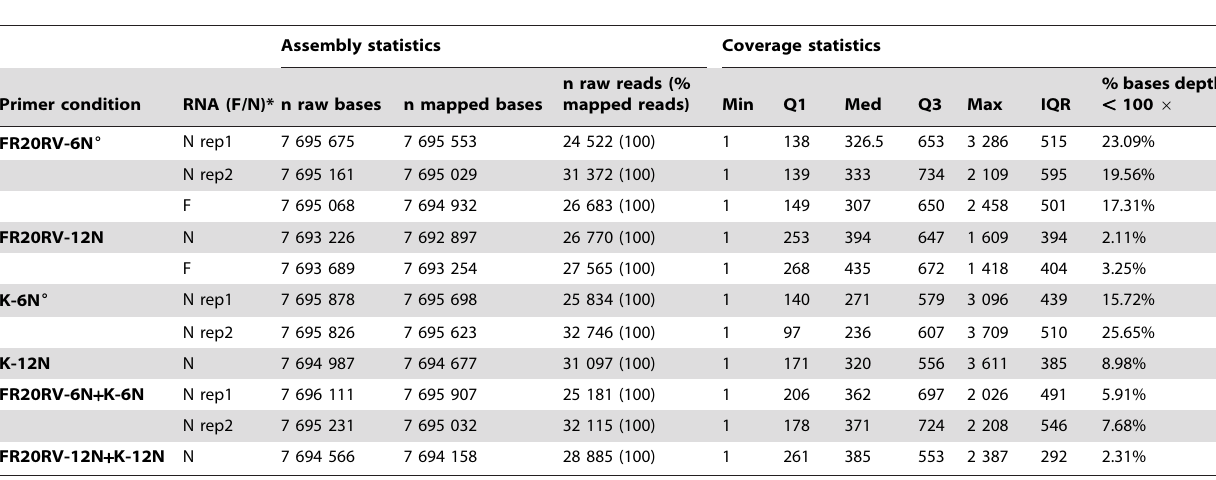
Table 1. Summary of experimental conditions tested on APMV-8 and their assembly and coverage